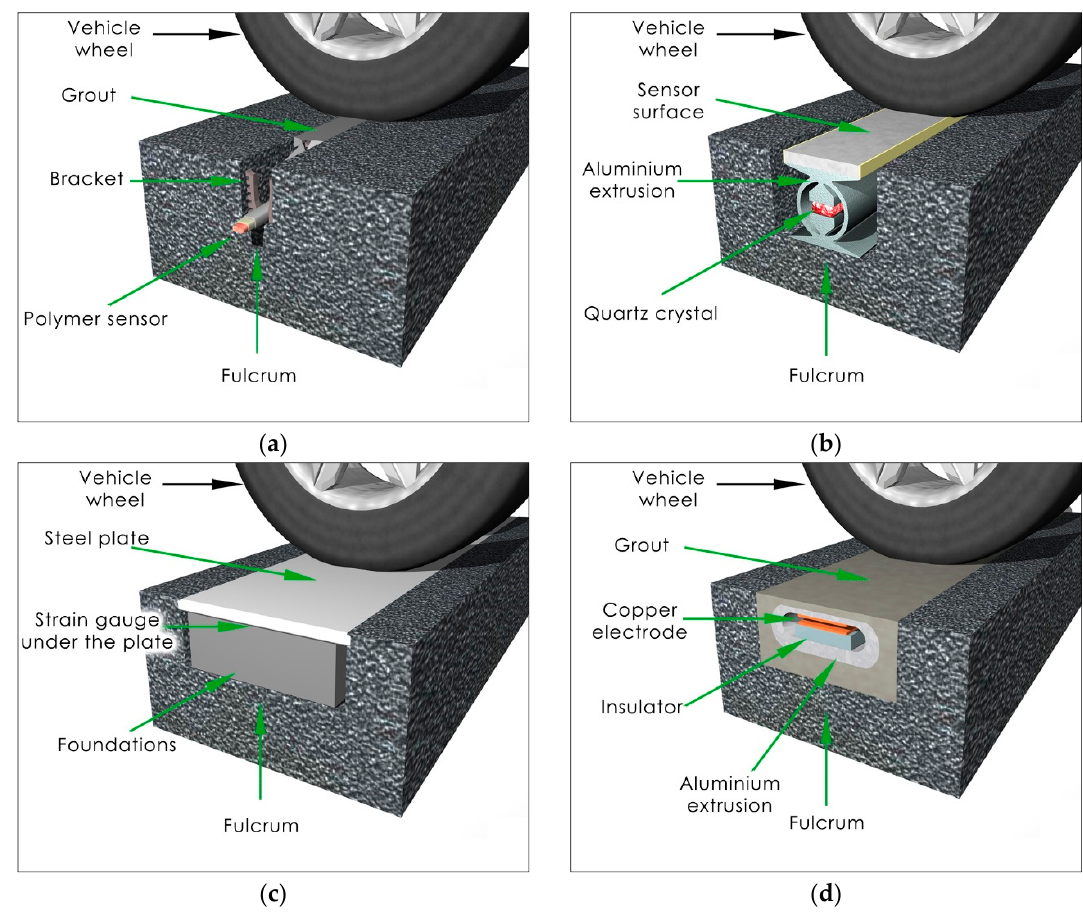
Figure 3. ( a ) Polymer sensor installed below the pavement surface; ( b ) Quartz sensor installed on the level of the pavement surface; ( c ) Bending plate sensor installed on the level of the pavement surface; ( d ) Capacitive sensor installed on the level of the pavement surface.